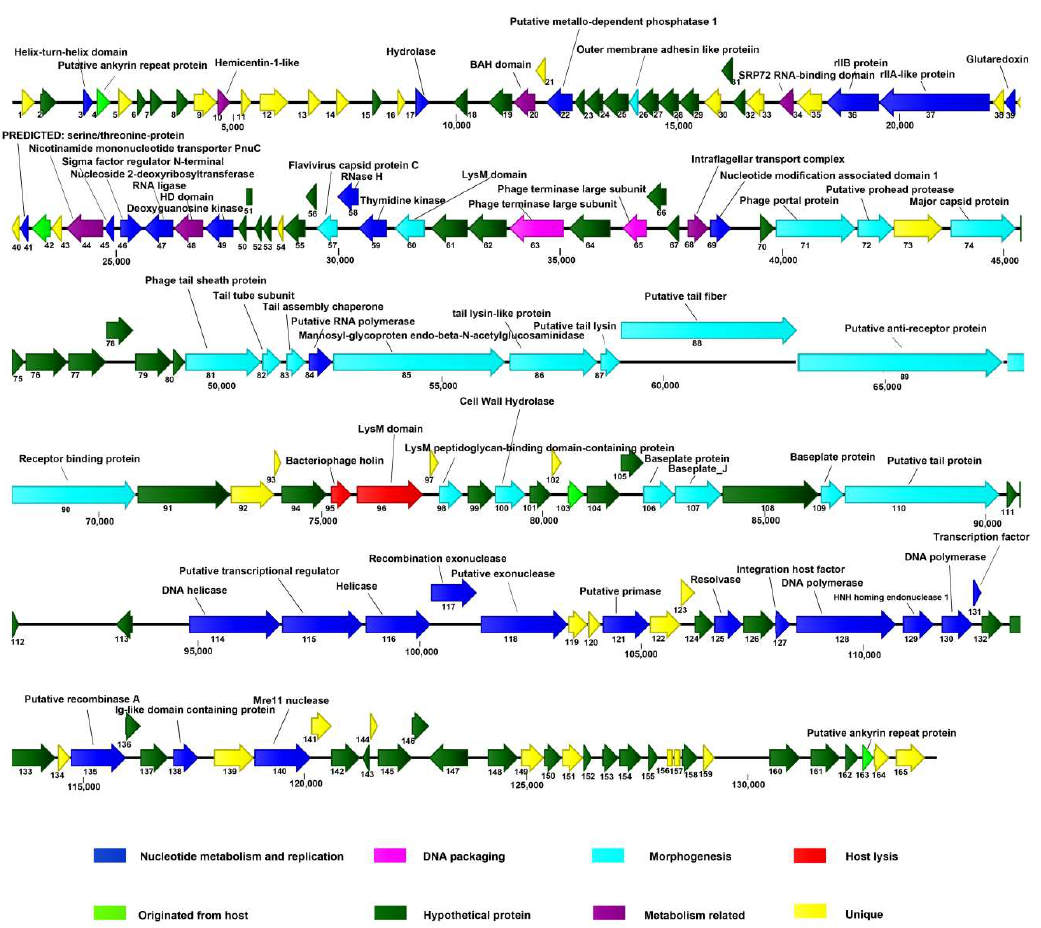
Figure 4. Graphical representation of the vB_AviM_AVP (AVP) genome. The 165 ORFs are depicted and the direction of transcription is indicated by arrows. Proposed modules are based on hypothetical functions predicted through bioinformatic analysis. The genome map was drawn using CLC Main Workbench, version 7.7.3 (CLC Bio-Qiagen, Aarhus, Denmark).